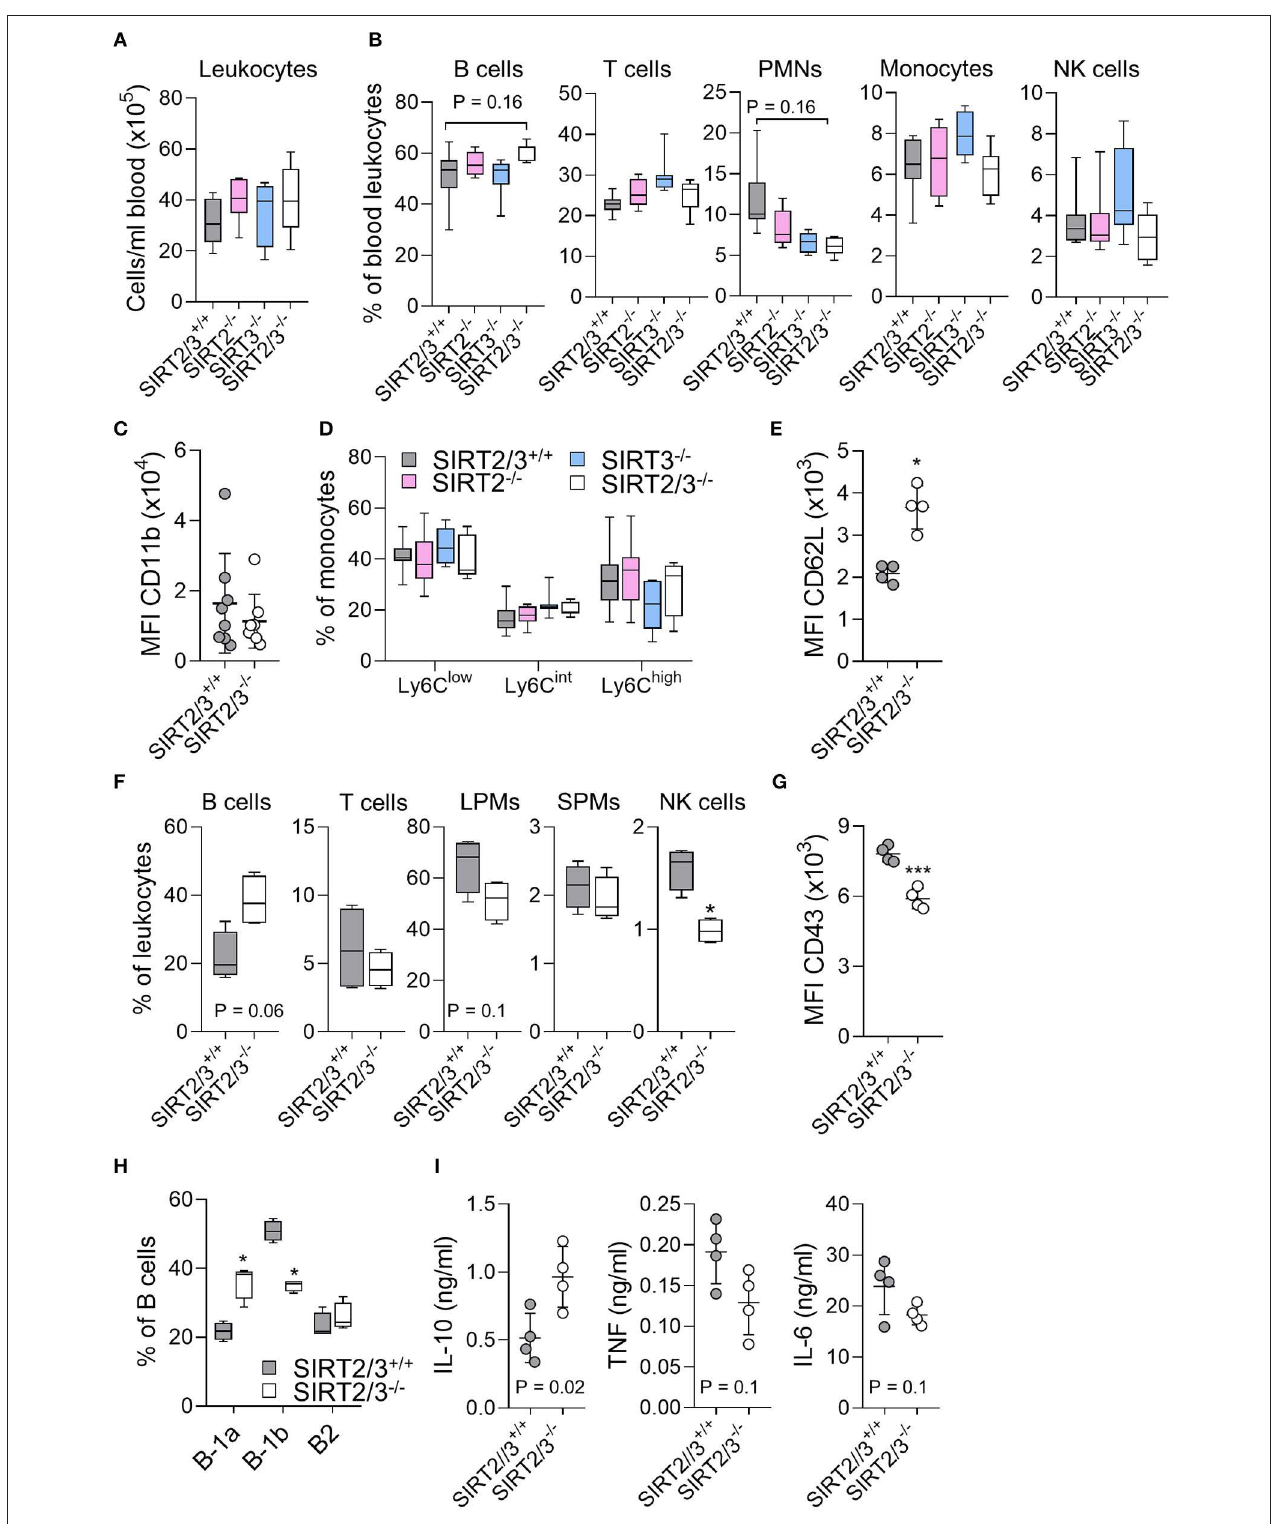
FIGURE 2 | SIRT2/3 − / − mice have minor alterations of blood and peritoneal leukocyte subpopulations. (A–E) Absolute number of CD45 + leukocytes (A) and percentages of CD19 + B cells, CD3 + T cells, Ly6G + PMNs, CD11b + Ly6G − monocytes and NK1.1 + NK cells (B) in peripheral blood of SIRT2/3 + / + , SIRT2 − / − , SIRT3 − / − , and SIRT2/3 − / − mice. (C) Mean fluorescence intensity (MFI) of CD11b expressed by SIRT2/3 + / + and SIRT2/3 − / − PMNs. (D) Percentage of Ly6C